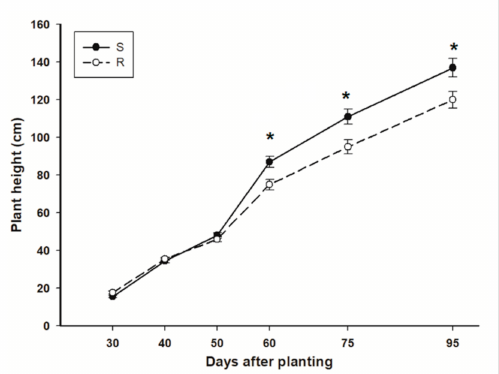
Figure 1. Plant height of imazamox-resistant (R) and susceptible (S) wild poinsettia plants. * indicates significant di ff erences at p < 0.05. Vertical bars ± standard error ( n =